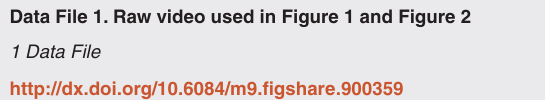
Data File 1. Raw video used in Figure 1 and Figure